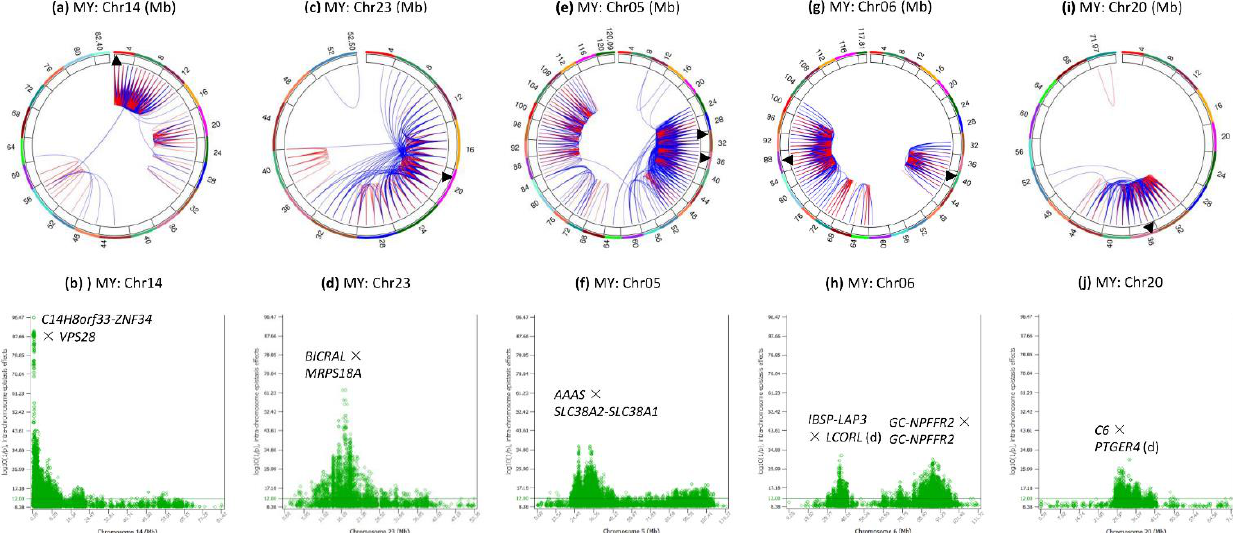
Figure 5. Chromosomes with most significant intra-chromosome epistasis effects for milk yield. The top row shows the circular plots with red color indicating intra-4 Mb epistasis effect and blue color indicating inter-4 Mb epistasis effects; the bottom row shows the Manhattan plots of log10(1/p) values, where p = the 5% genome-wide type-I error with the Bonfer- roni multiple testing correction. The black arrow indicates the location of the peak epistasis effect of the chromosome. Gene name indicates the gene with a peak SNP epistasis effect, and ‘-’ indicates the SNP was between the two genes. MY = milk yield. ( a ): Intra-chromosome epistasis effects of Chr14 for milk yield. ( b ): Statistical significance of intra-chromosome epistasis effects of Chr14 for milk yield. ( c ): Intra-chromosome epistasis effects of Chr23 for milk yield. ( d ): Statistical significance of intra-chromosome epistasis effects of Chr23 for milk yield. ( e ): Intra-chromosome epistasis effects of Chr05 for milk yield. ( f ): Statistical significance of intra-chromosome epistasis effects of Chr05 for milk yield. ( g ): Intra-chromosome epistasis effects of Chr06 for milk yield. ( h ): Statistical significance of intra-chromosome epistasis effects of Chr06 for milk yield. ( i ): Intra-chromosome epistasis effects of Chr20 for milk yield. ( j ): Statistical significance of intra-chromosome epistasis effects of Chr20 for milk yield.